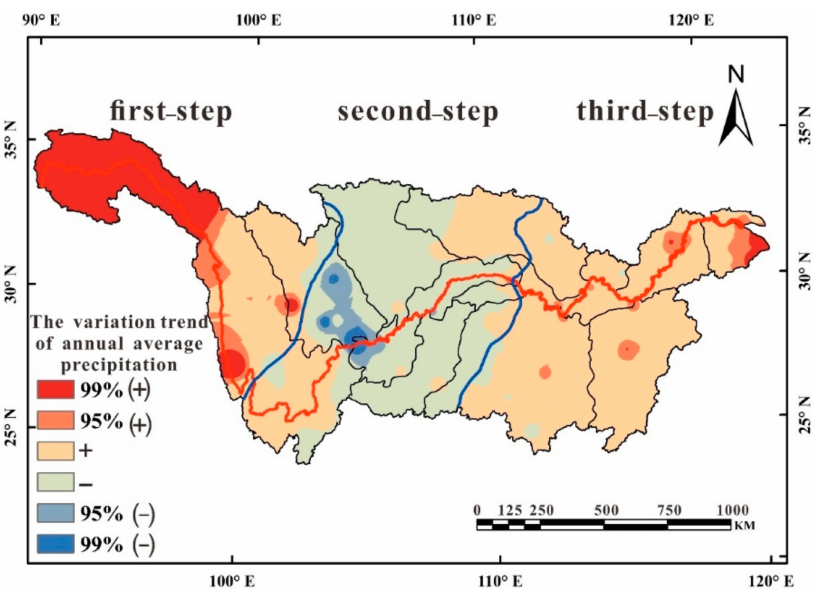
Figure 7. Spatial distribution of annual rainfall variation trends in the YRB from 1961 to